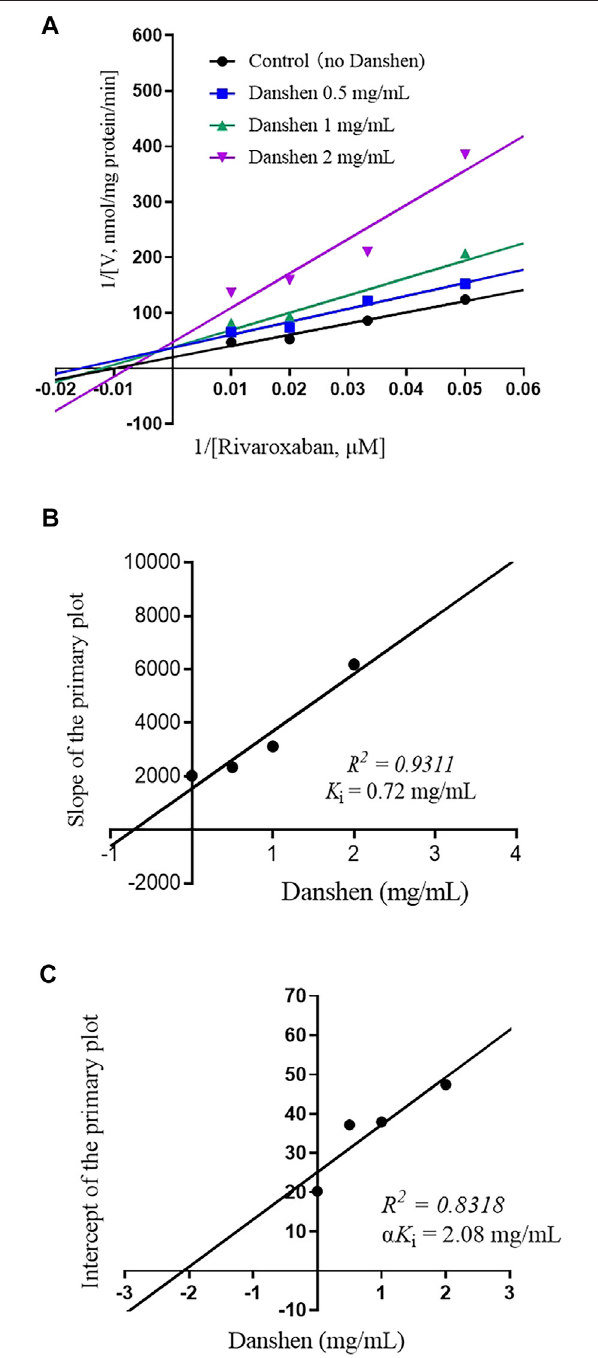
FIGURE 2 | Primary Lineweaver – Burk plot (A) , the secondary plot for K i, (B) , and the secondary plot for α K i (C) for the inhibition of rivaroxaban metabolism by Danshen tablet with various concentrations (0.5, 1, and 2 mg/ mL) in RLM. Rivaroxaban was used at 20, 30, 50, and 100 μ M. Each data point represents the mean of quadruplicate